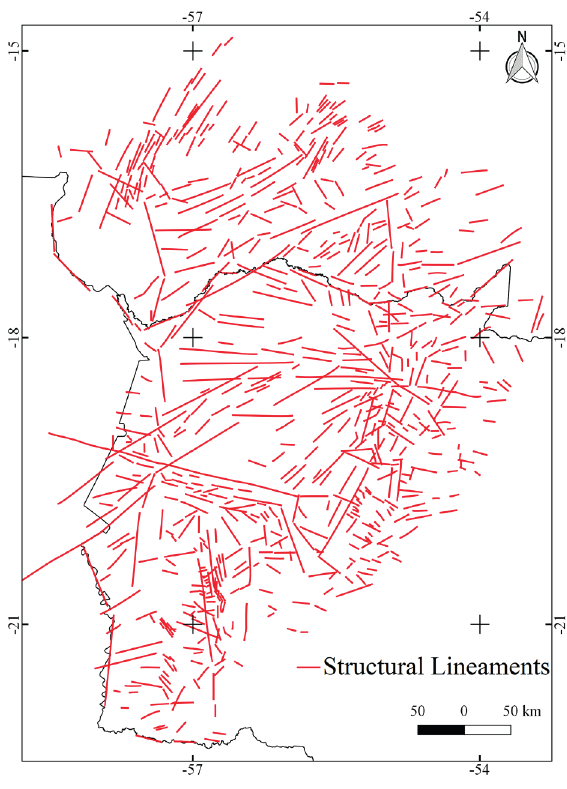
Figure 4 - Structural lineaments proposed by Paranhos Filho et al. (2013), obtained from satellite CBErS-2B, sensor MODIS